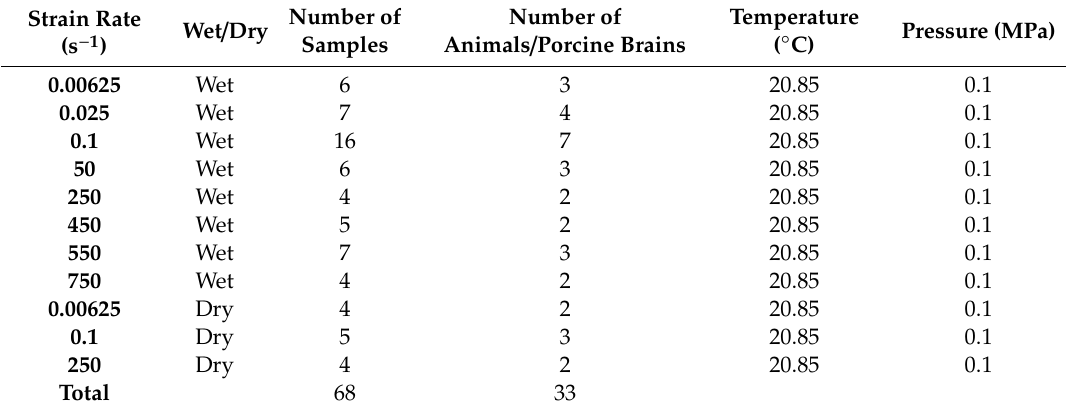
Table 1. Details of samples, animal brain numbers, and testing conditions at each strain rate Strain